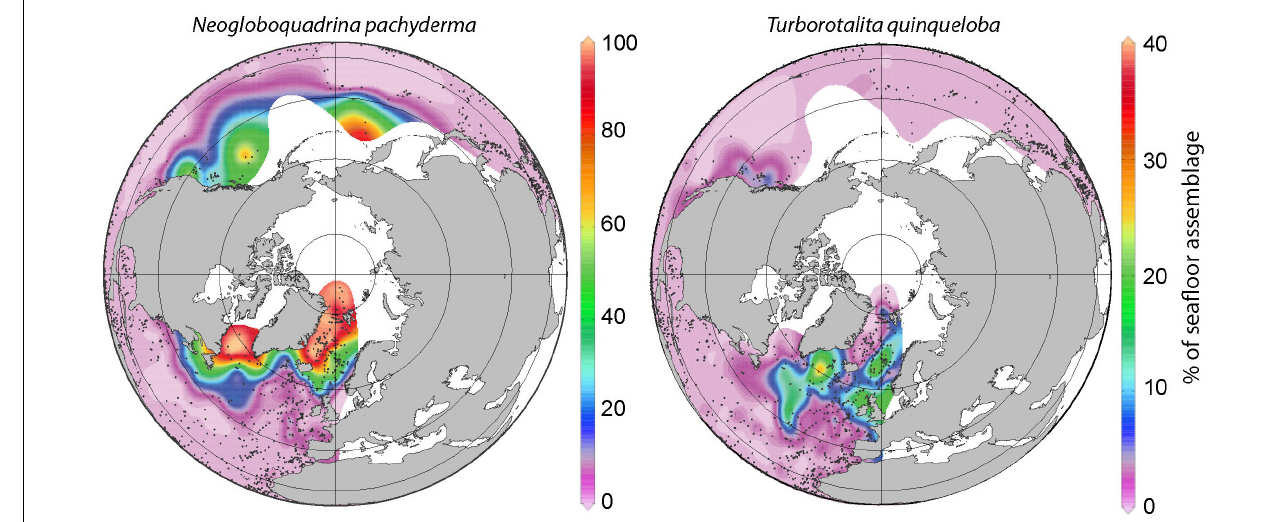
FIGURE 2 | Distribution of Neogloboquadrina pachyderma and T. quinqueloba in high northern latitude surface sediments. Gridded distributions produced with Ocean Data View (http://odv.awi.de) (Schlitzer, 2018) using the database from Kucera et al. (2005a) and published in Kucera et al.